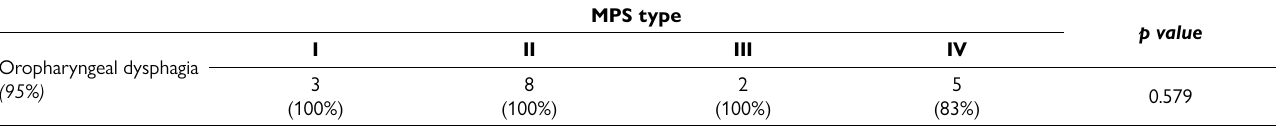
Table 1. Prevalence of oropharyngeal dysphagia in patients with